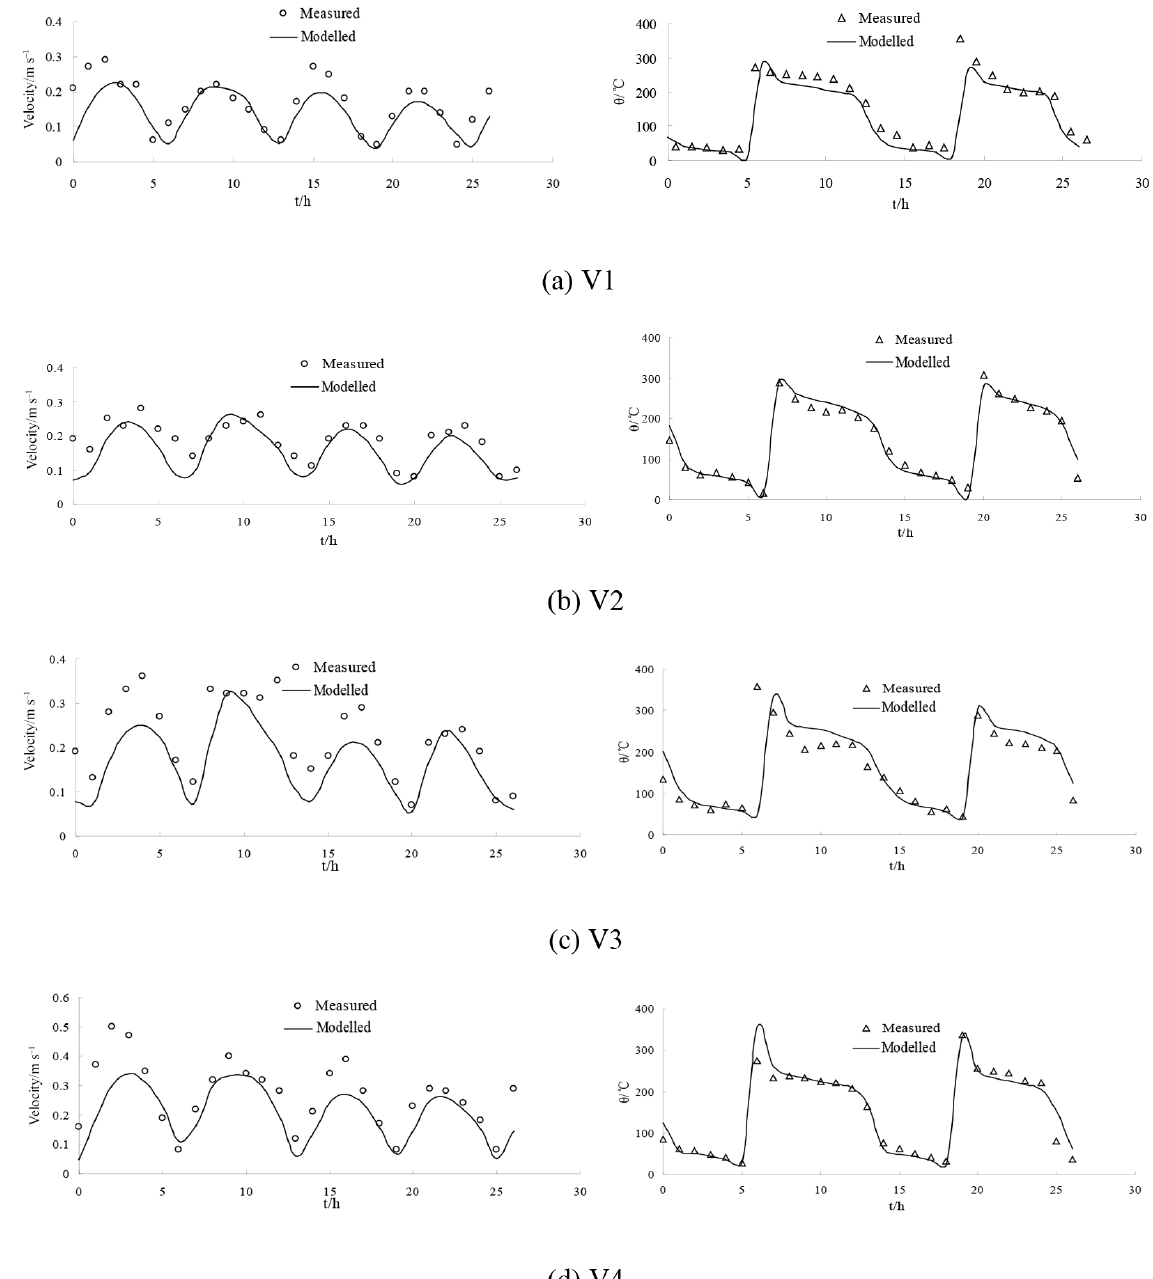
Figure 5. The validation of current speed (left side) and direction (right side) at measured stations during neap